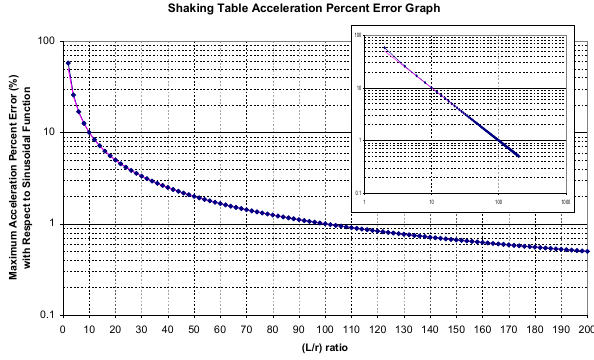
Fig. 5 Shaking table maximum acceleration error change as a function of L/r ratio. Fig. 5. Shaking table maximum acceleration error change as a func- tion of L/r